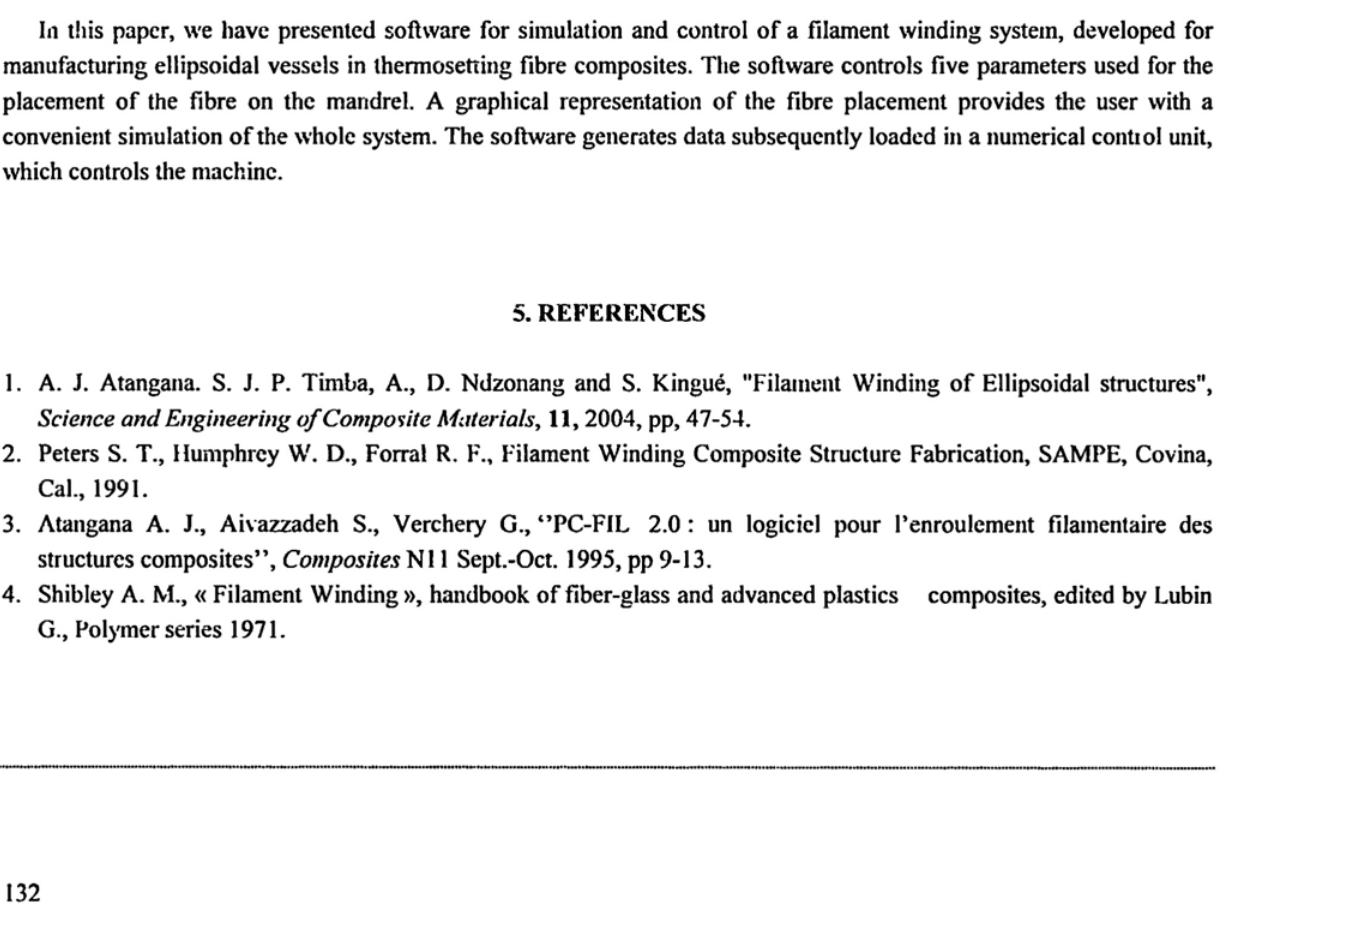
Fig. 6: An example of use of the previously mentioned